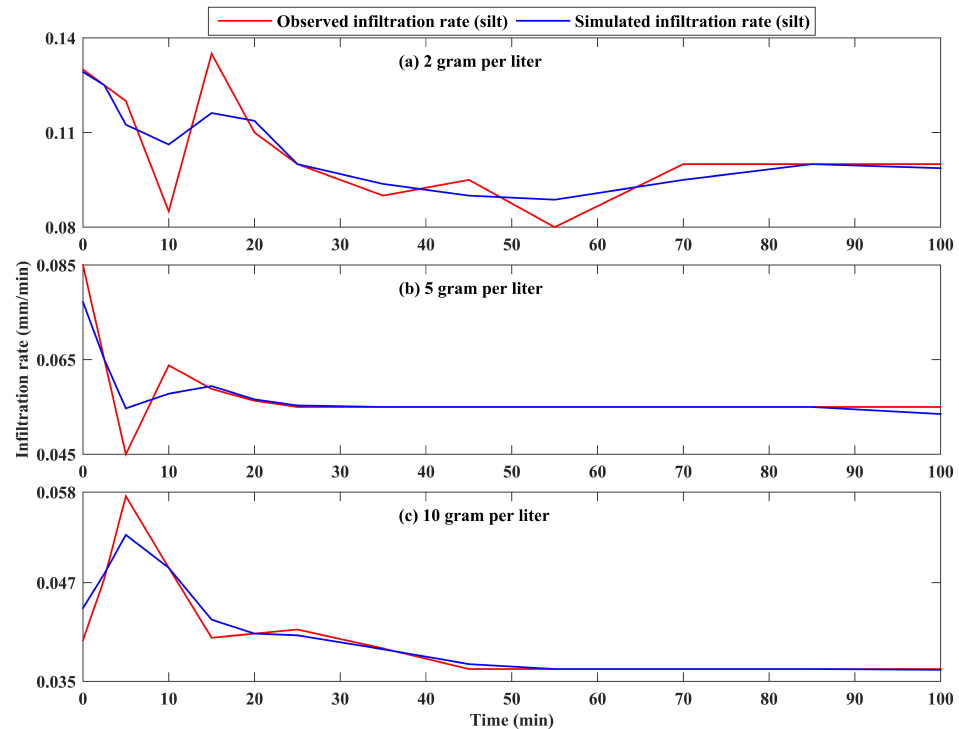
Figure 6. Comparison of the infiltration rate observed for the clean water (0 g/L) with that of the reconstructed using SSA for clay-sized suspended solids under three concentration levels 2, 5 and 10 g/L.